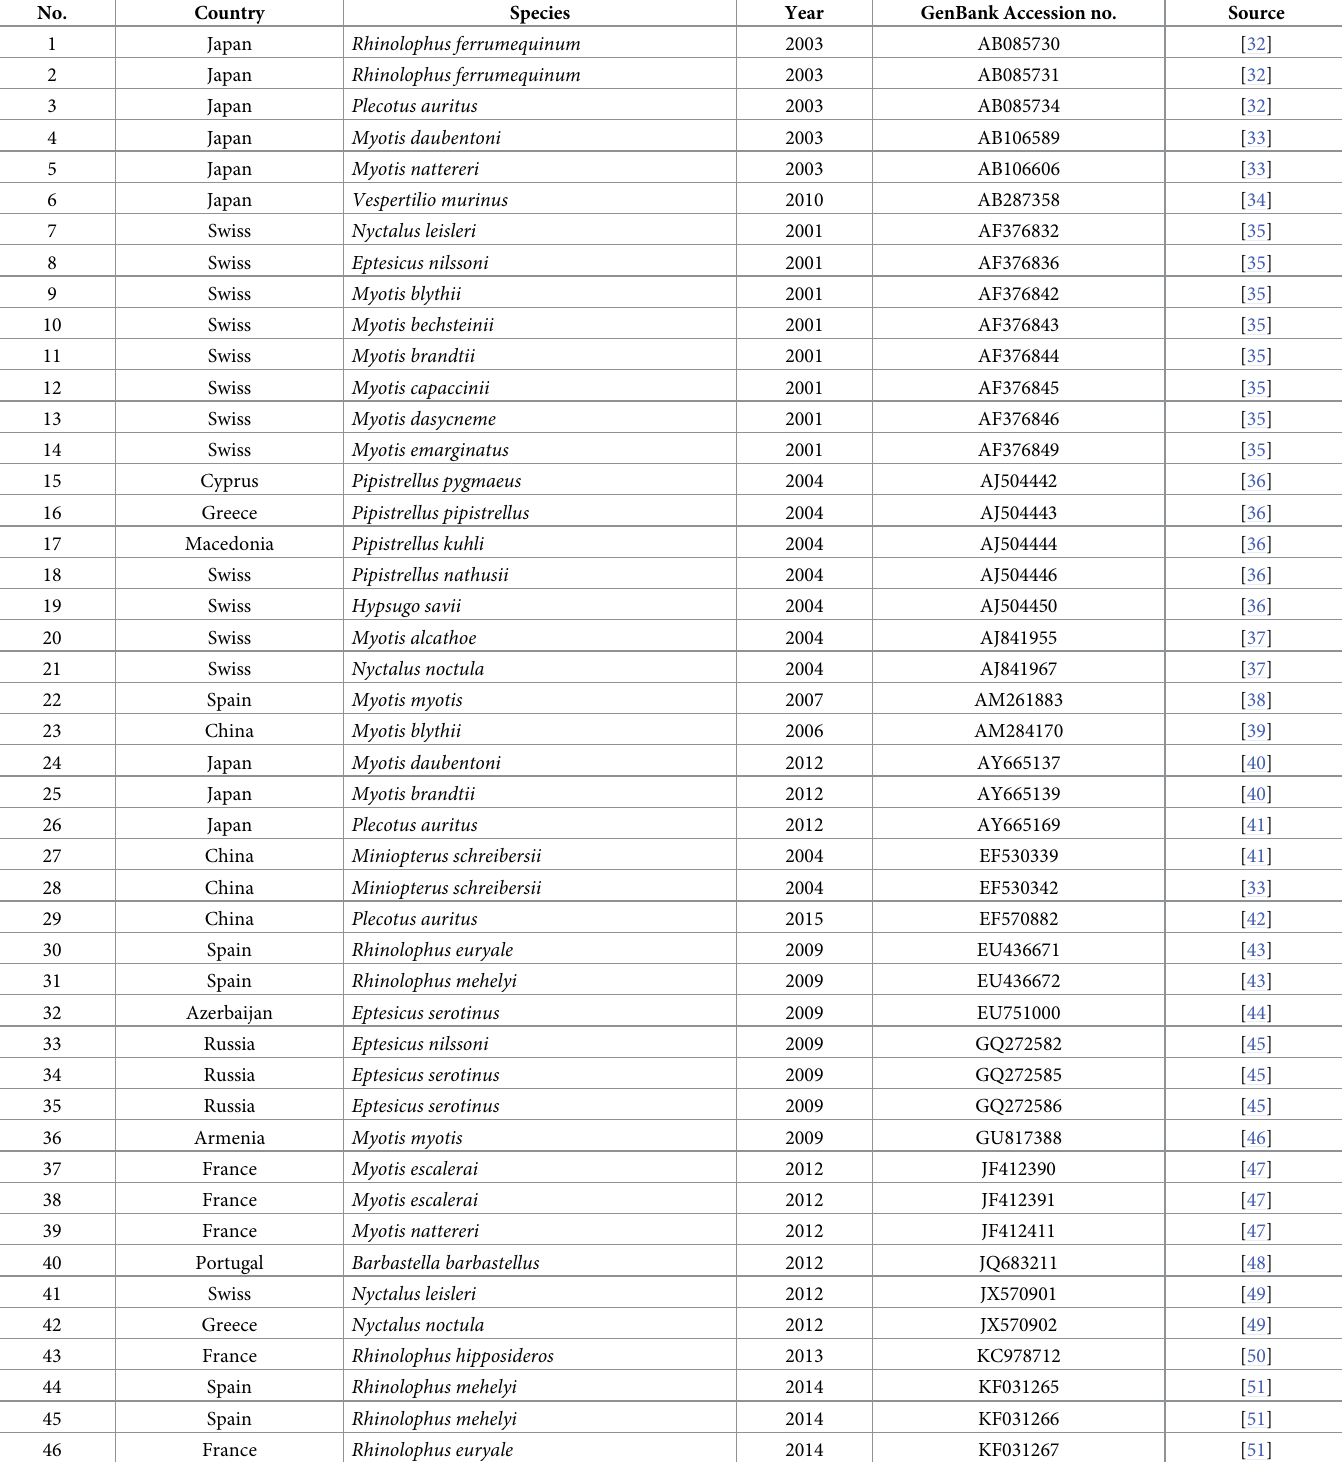
Table 4. Characteristics of the partial cytochrome b gene reference sequences retrieved from GenBank and other sequences amplified from wing punches and bat guano from this study.